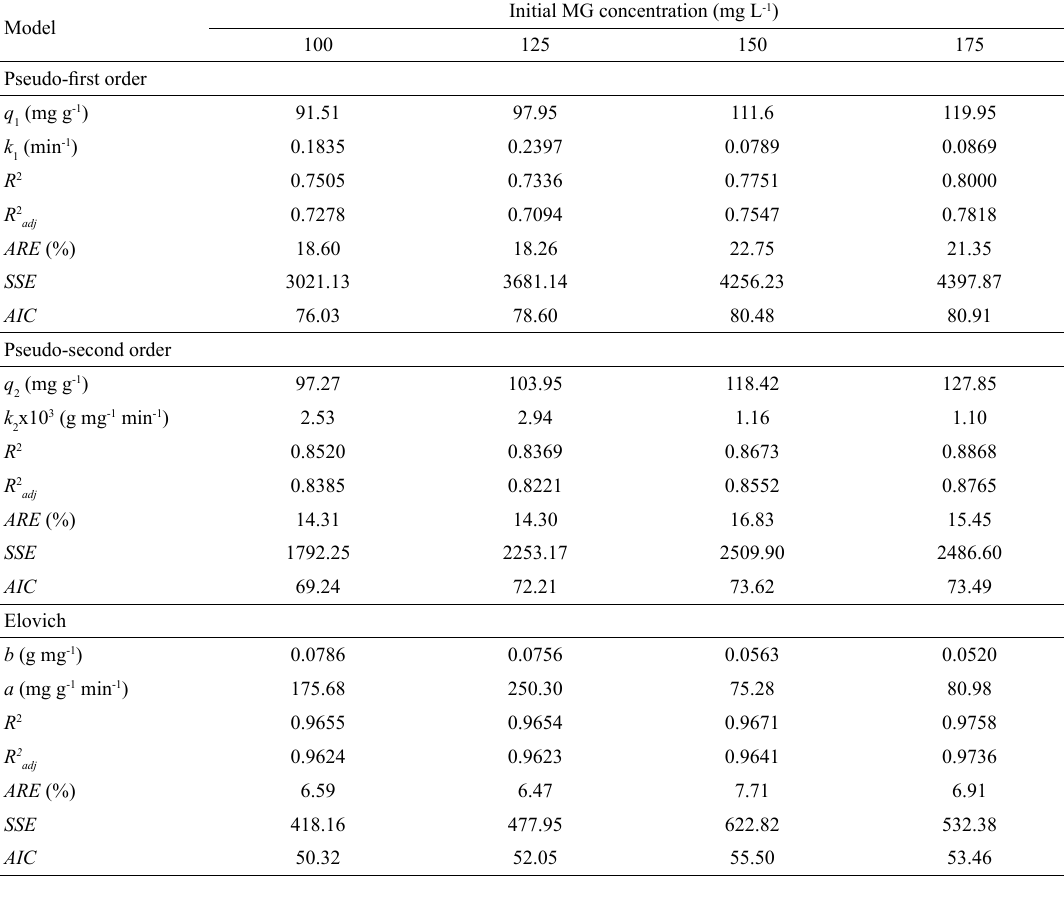
Table 1. Kinetic parameters for the adsorption of MG onto natural kaolin. Model